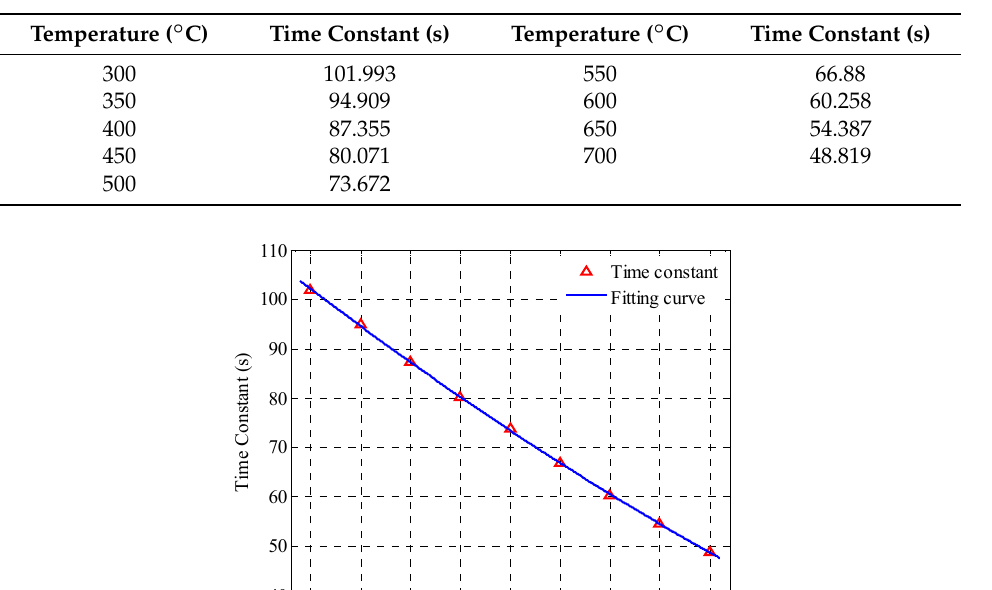
Table 4. Time constants at different temperatures